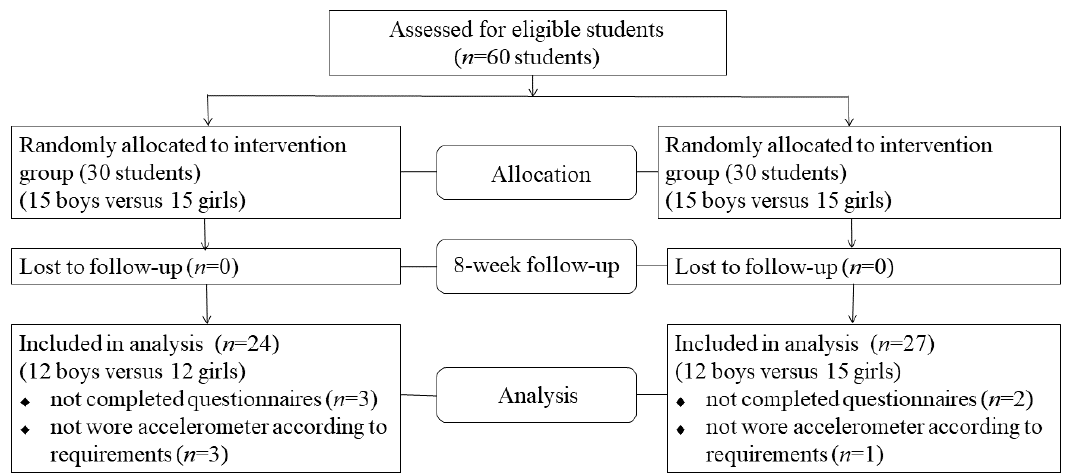
Figure 1. Flowchart of study design.